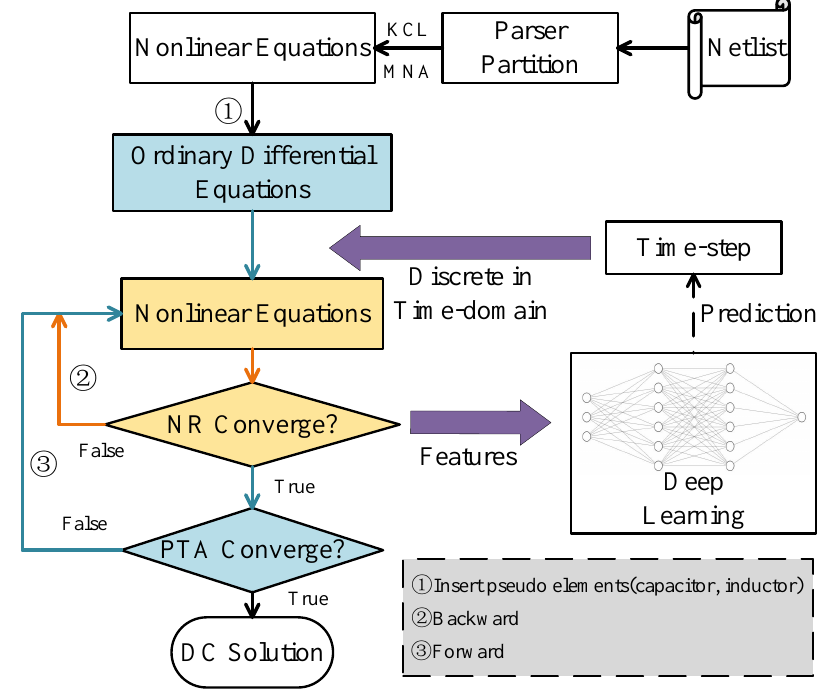
Figure 1. The framework of the time-step control method enhanced by deep